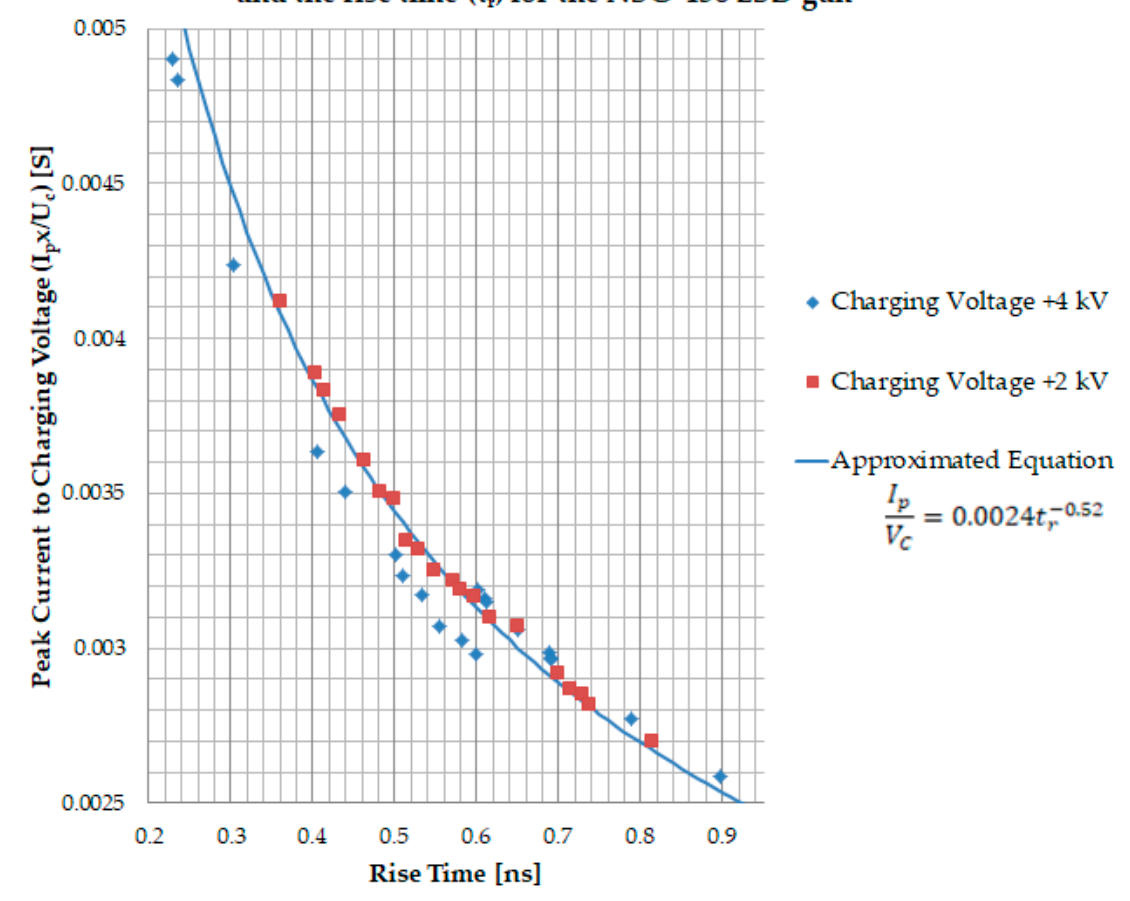
Figure 9. Relationship between the peak current to charging voltage ( I p /U c ) and the rise time ( t r ) for the NSG-438 ESD gun.